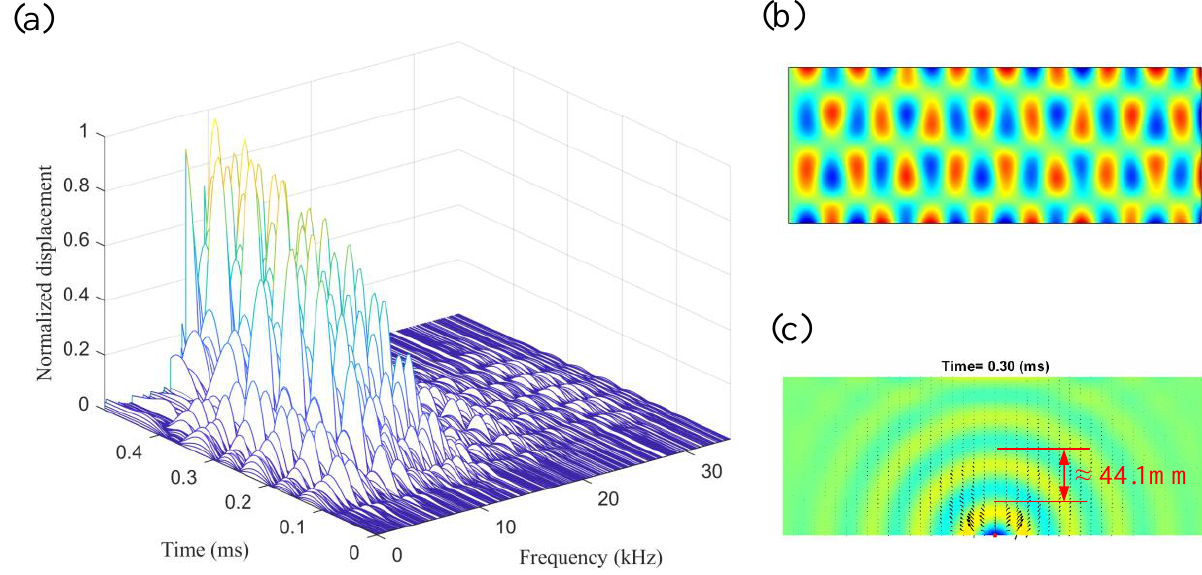
Figure 4. ( a ) The relationship of the displacement of the flexural waves with respect to the time and each vibration mode at its resonant frequency. ( b ) The 129th mode shape around 10 kHz with a resonant frequency of 10,077 Hz ( c ). The full-field displacement response at 0.3 ms, where the flexural wavelength is 44.1 mm.